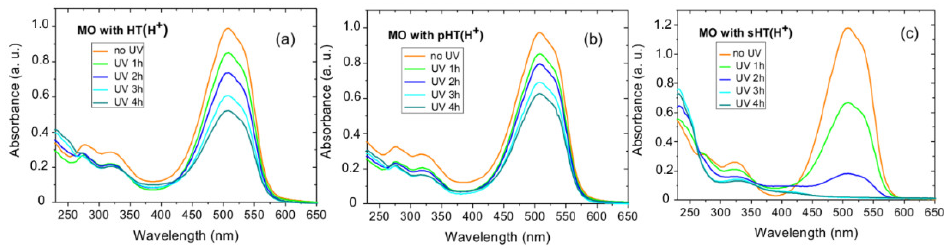
Figure 6. UV-Vis absorbance spectra of MO in HT(H + ) ( a ), pHT(H + ) ( b ) and sHT(H + ) ( c ) dispersions, respectively, at pH < 3 and after exposure to UV-Visible light irradiation for different times.